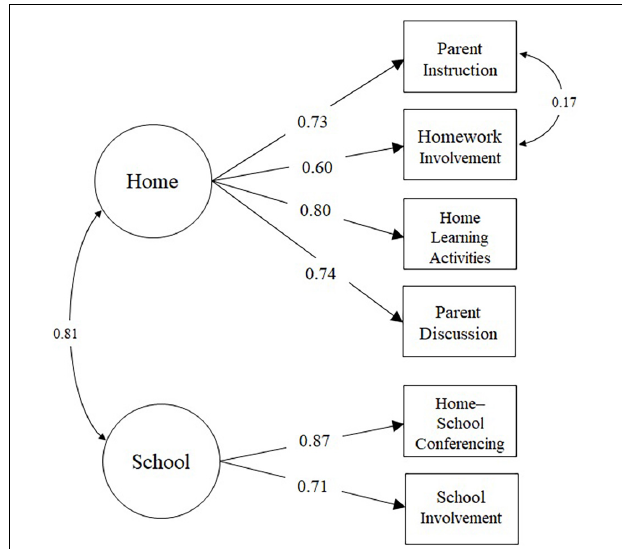
FIGURE 3 | Confirmative factor analysis